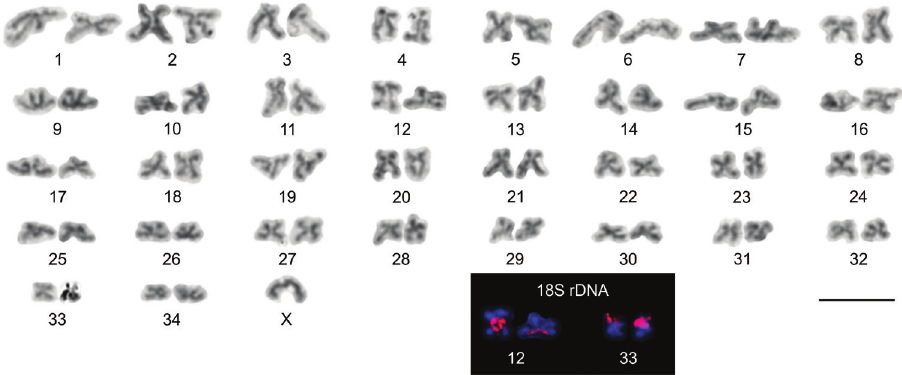
Figure 5. Neobisium slovacum , male karyotype from Šingliarova chasm after Giemsa staining. Inset (black box) shows chromosomes detected by FISH with 18S rDNA (red signal). Based on two sister metaphase II plates. Scale bar: 10